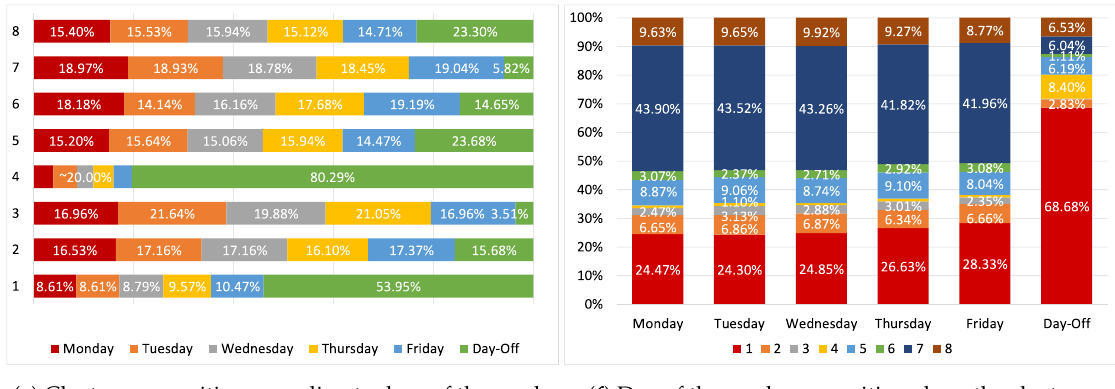
Figure 8. Cluster analysis depending on buildings, seasons of the year, and days of the